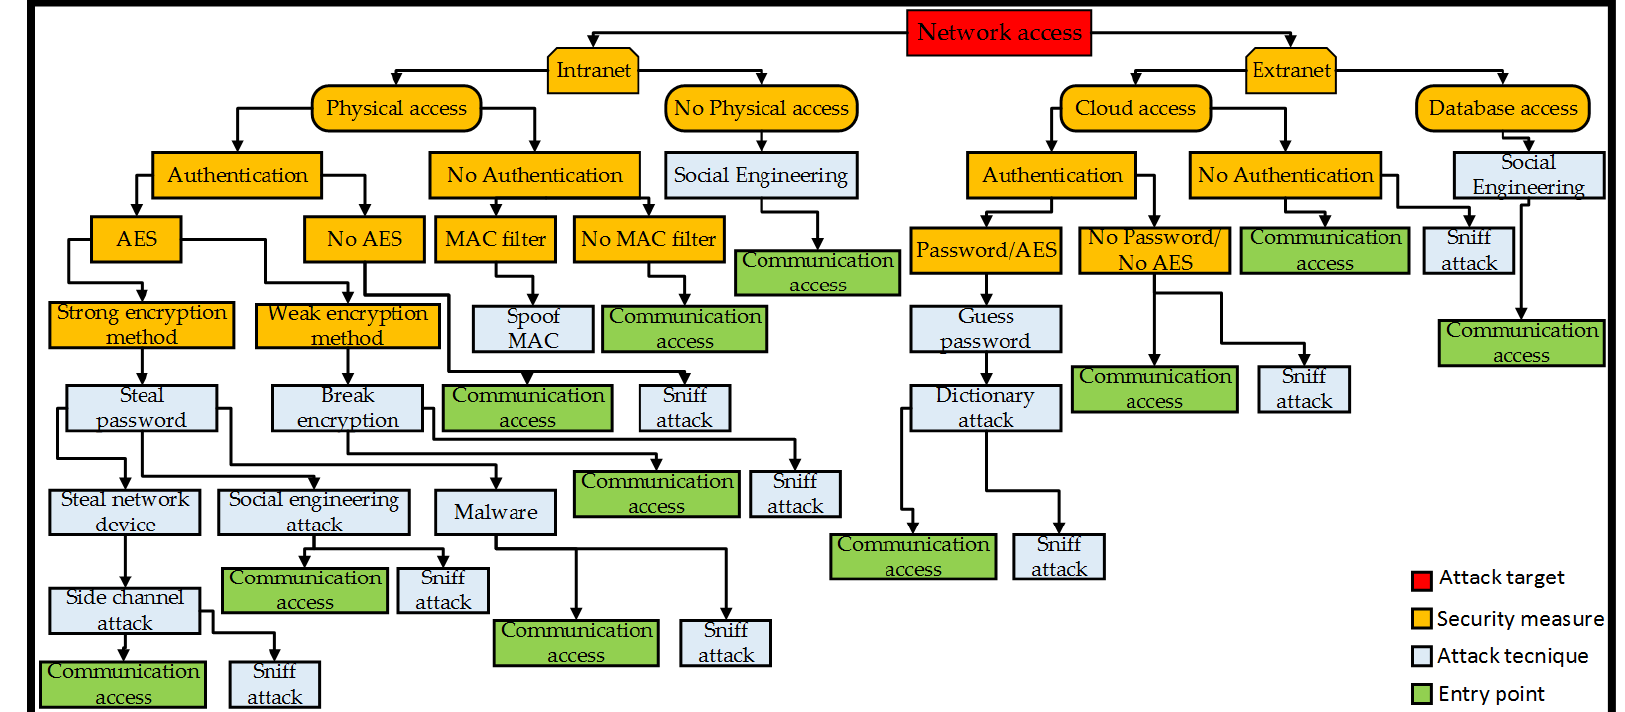
Figure 7. Network access attack tree. MAC: Media access control; AES: Advanced Encryption Standard.